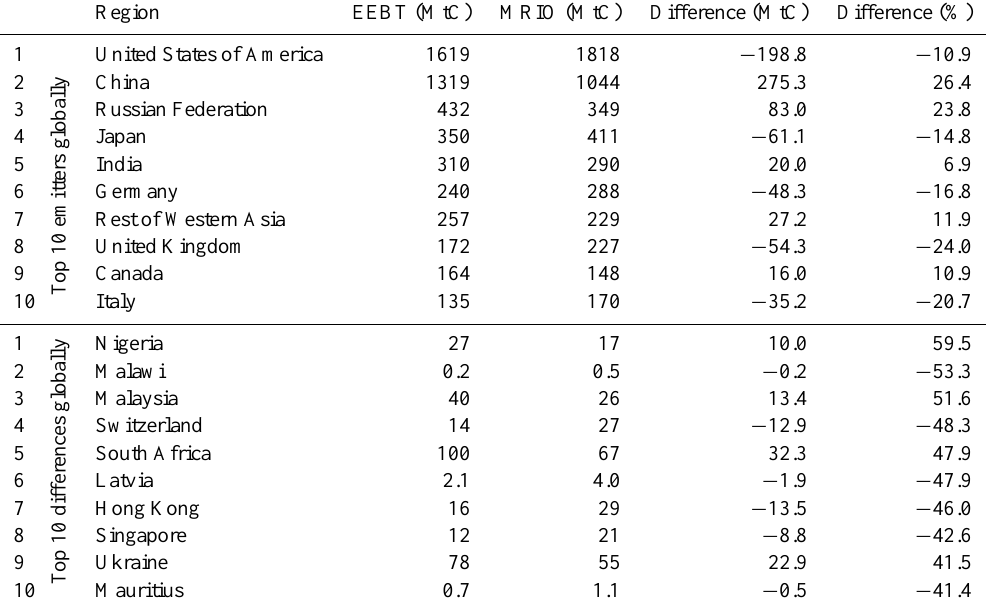
Table 6. The differences resulting from using different definitions for consumption-based inventories (2004), showing the top 10 emitters in terms of consumption. The differences are measured relative to the MRIO definition.